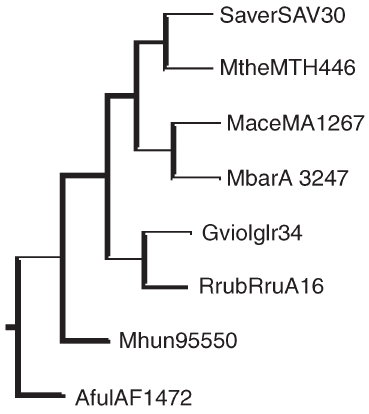
Figure A5. Phylogenetic analysis by neighbor-joining of putative two-component open reading frames (ORFs) from hybrid kinase 1 group ahy2 . The bacterial ORFs are Gviolglr3434, RrubRruA1653 and SaverSAV3017. Abbreviations: Gviolglr3434 = G. violaceus ; RrubRruA1653 = R. rubrum ; and SaverSAV3017 = S. avermitilis